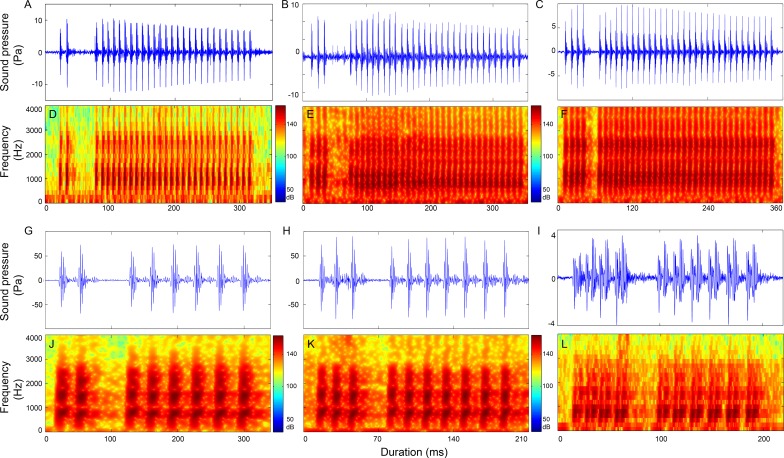
Representative oscillogram and sonogram of two section signals with the first section contain two pulses (2 + N9 in A and D and 2 + N18 in G and J), three pulses (3 + N9 in B and E and 3 + N17 in H and K) and four pulses (4 + N9 in C and F and 4 + N17 in I and L).Oscillograms in row 1 (A–C) and the corresponding sonograms in row 2 (D–F) are call types with IPPIs medians at 9 ms, whereas oscillograms in row 3 (G–I) and its corresponding sonograms in row 4 (J–L) are call types with IPPIs medians at 17 ms.